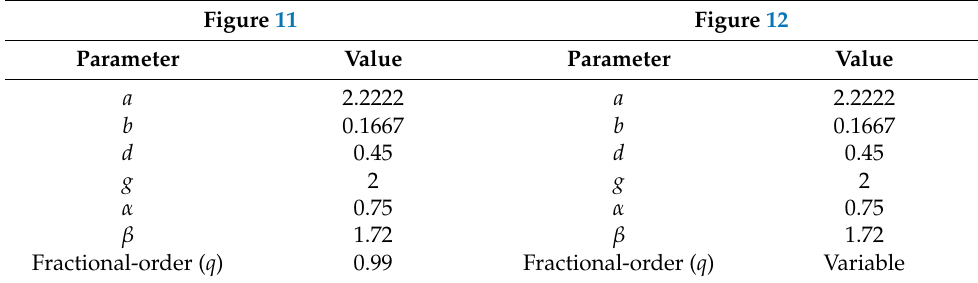
Table 3. The system (17) parameters utilized in examination Lyapunov